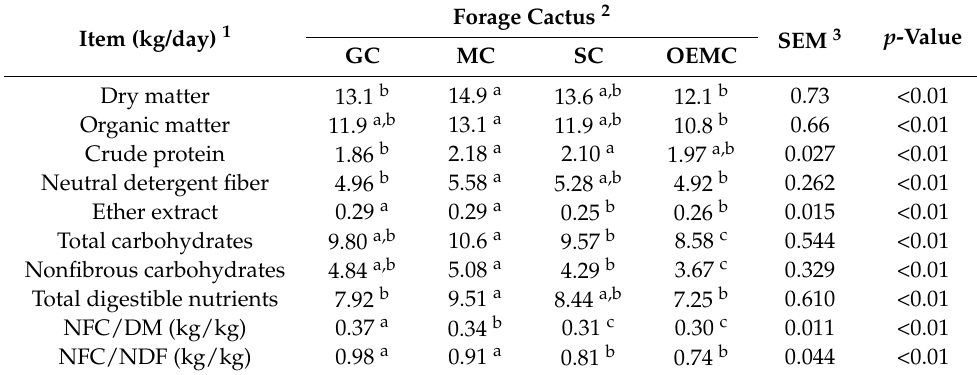
Table 3. Effects of forage cactus genotypes on nutrient intake ( n = 8).